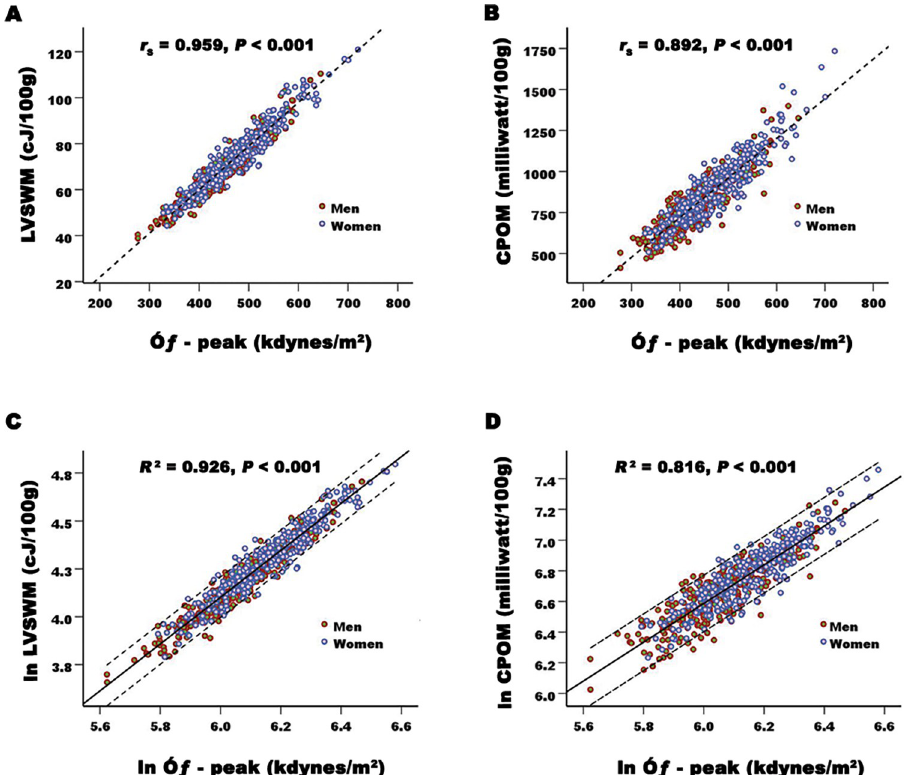
Fig 2. Linear correlation and regression between the LVSWM and O´ ƒ —peak, and between CPOM and O´ ƒ —peak in 596 apparently healthy adults (298 men). Very strong correlation exists between the LVSWM and the O´ ƒ —peak (A), and a strong correlation exists between the CPOM and the O´ ƒ —peak (B). The natural logarithm of LVSWM, CPOM, and the O´ ƒ —peak are normally distributed data. C and D show that both the LVSWM and the CPOM increase with O´ ƒ —peak (ln LVSWM = -3.233 + 1.223 × ln O´ ƒ —peak; and -1.007 + 1.266 × ln O´ ƒ —peak). These figures indicate that the higher the LV myocardial afterload is, the more work has to be done by per unit myocardium. Abbreviations as Table